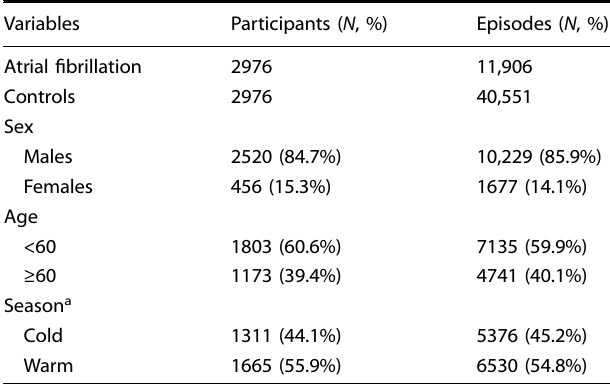
Table 1. Descriptive statistics on study participants and atrial fi brillation